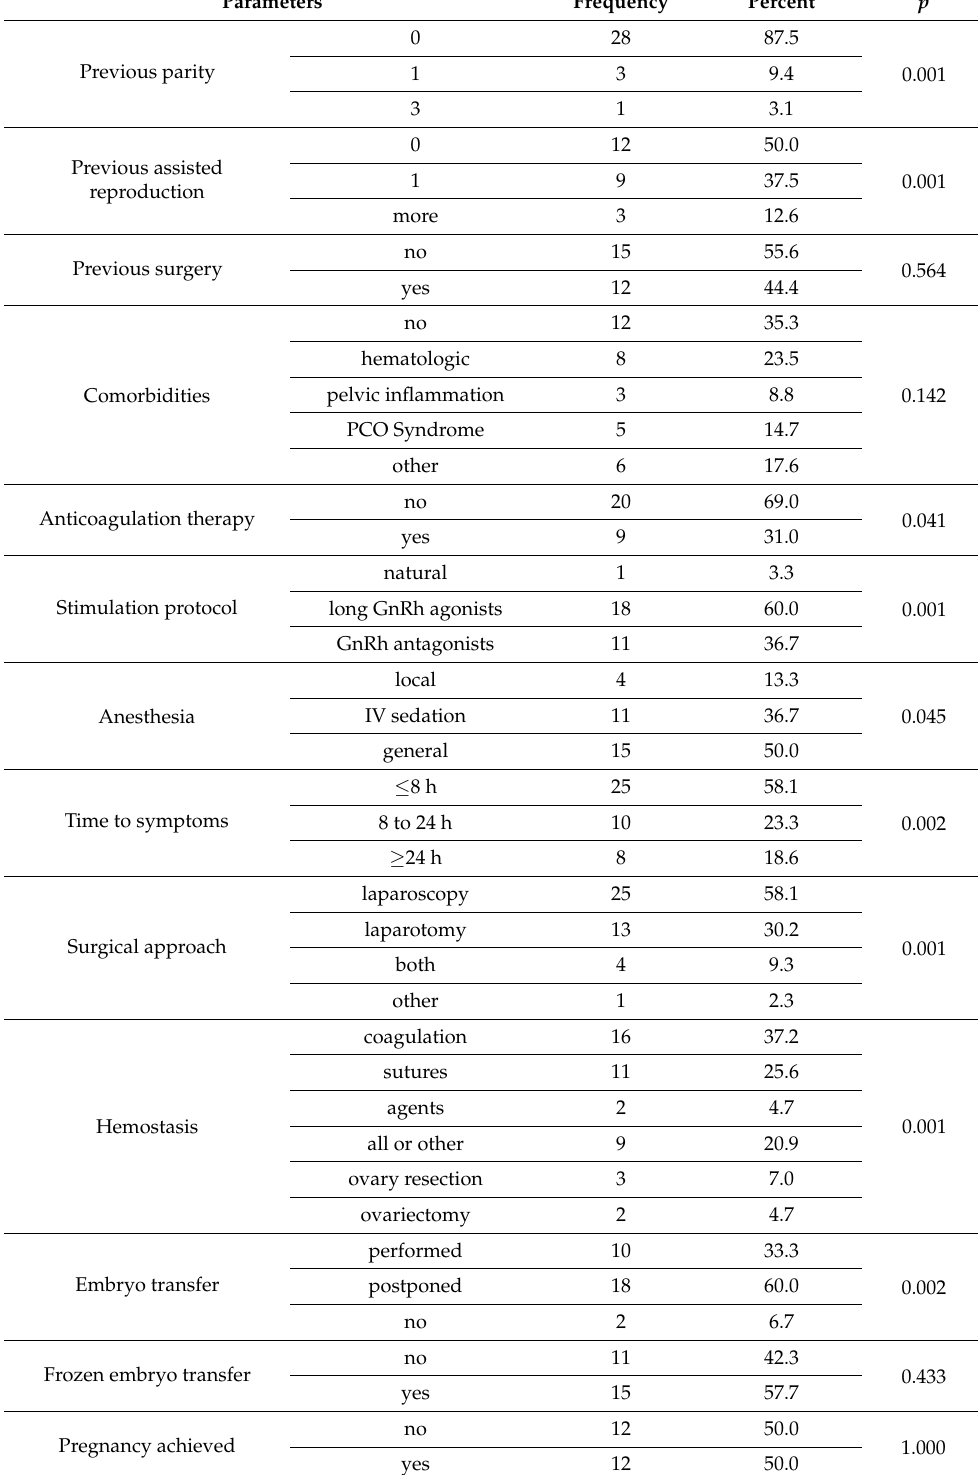
Table 3. Frequency of investigated parameters of pooled sample (patients from our Clinic and previous